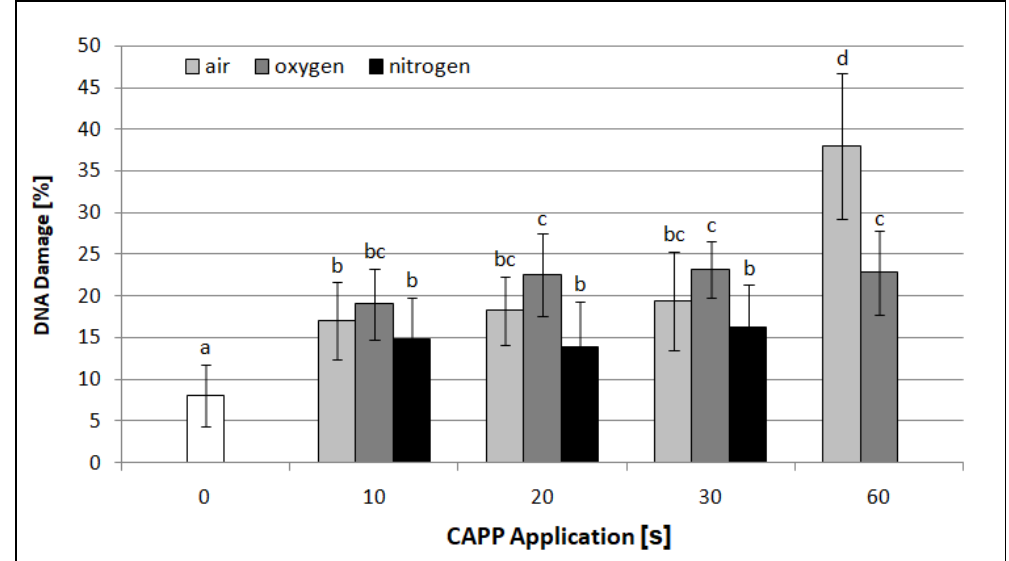
Figure 6. Graphical representation of the DNA damage effect of CAPP generated in ambient air, oxygen and nitrogen at exposure times of 10–60 s in barley leaves analyzed by comet assay. At least 100 nuclei were analyzed per slide. The data were analyzed using the statistical method LSD (Least Significant Difference) ANOVA and comparisons between the mean values were considered significant at p ≤ 0.05. Bars are means of three experimental runs ± SD.